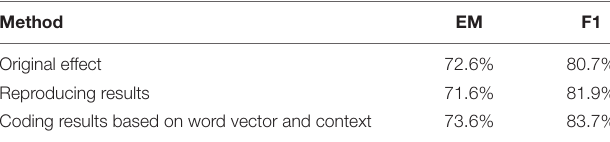
TABLE 3 | Comparison of experimental results based on word vector and context coding.